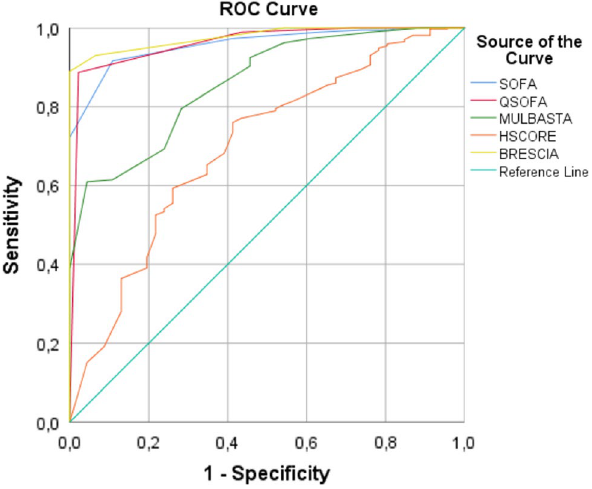
Figure 1. Receiver operating characteristic analysis of BRCSS, qSOFA, SOFA, MuLBSTA and HScore for severe disease of